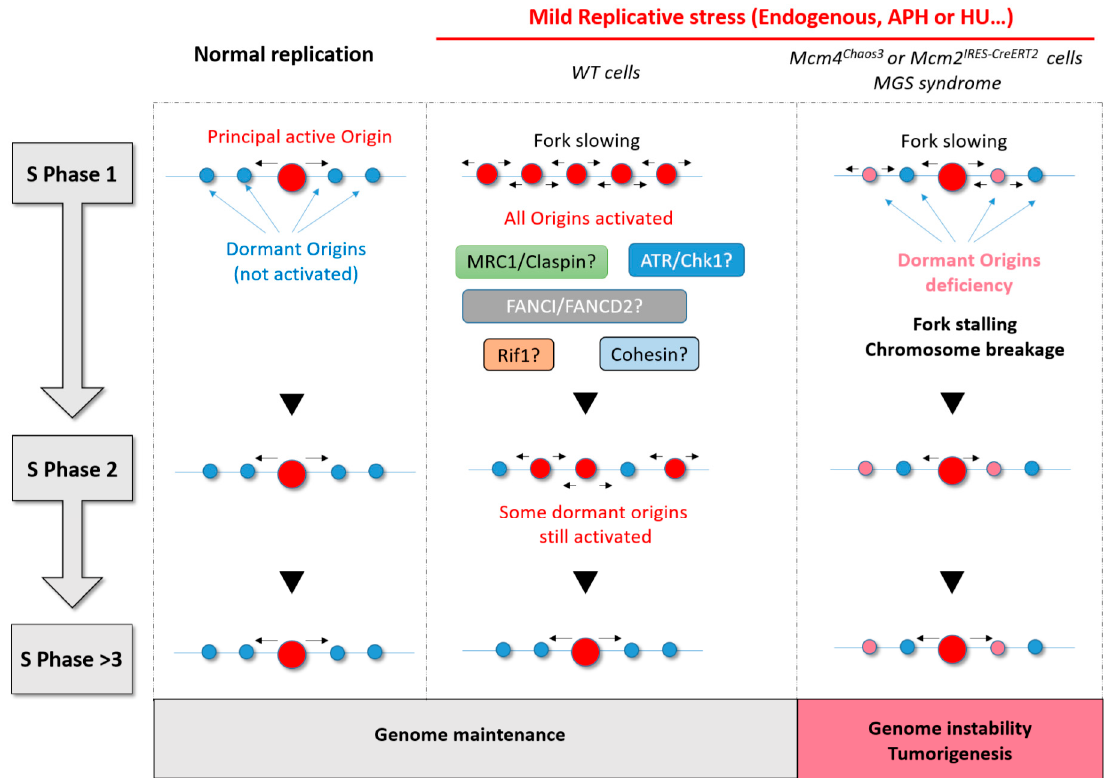
Figure 4. Summary diagram showing the importance of dormant origin activation in response to replicative stress. During normal replication, only the principal origin is activated. If there is no replicative stress, this same principal origin is also activated in the next S phase. Under conditions of mild replicative stress, adjacent or dormant origins fire to compensate for fork slowing and to allow complete replication on time. Many proteins (ATR/Chk1, mannose receptor C-type 1 (Mrc1)/Claspin, Fanconi anemia complementation group 1 (FANCI)/ Fanconi anemia complementation group D2 (FANCD2), and Rap1-interacting factor 1 (RIF1)) are thought to be involved in the regulation of dormant origins under mild replicative stress. RIF1 and Cohesin are two good candidates to explain the persistence of some origin activation in the next S phase. Finally, when cells have few origins or a deficiency in dormant origins, replicative stress leads inevitably to fork stalling, DNA breaks, and genomic instability with a consequent risk of tumorigenesis.